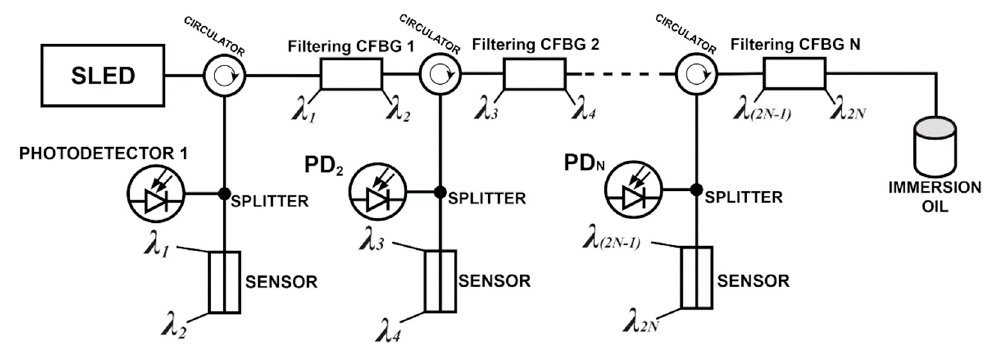
Figure 5. Scheme for abrasion sensor network that is based on CFBG— λ (2N-1) indicates initial wavelength that is being reflected from the CFBG N grating structure, while λ N is last wavelength that grating reflects.